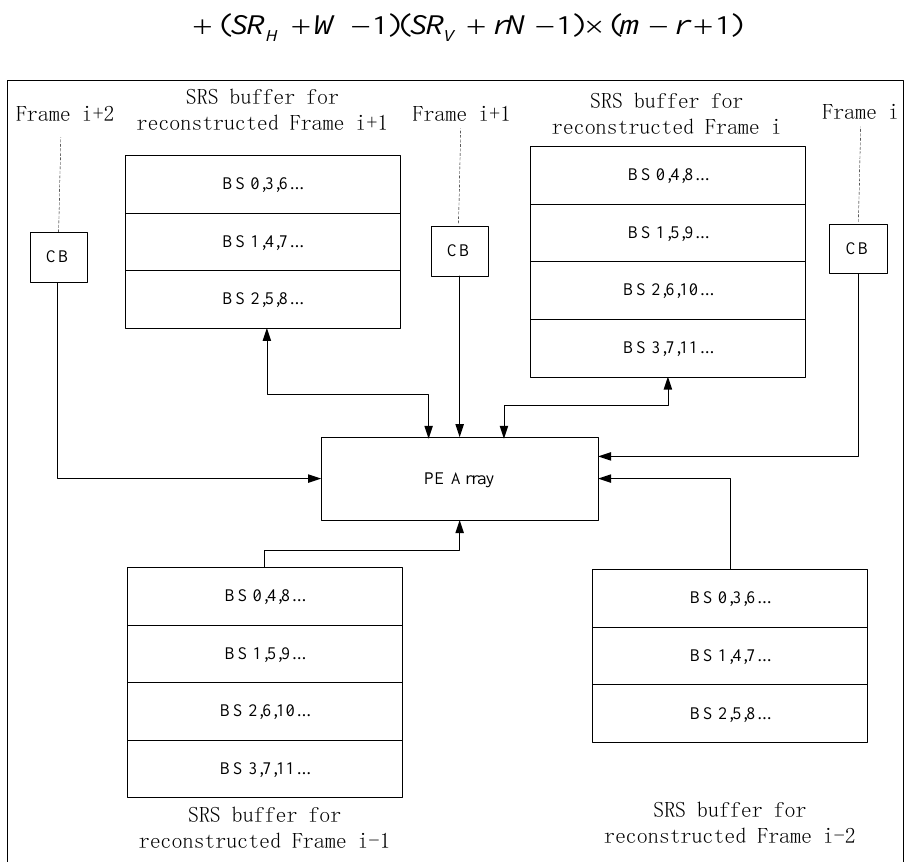
Figure 12. Inter-D architecture for VC-MRME. Three current frames (m = 3) are processed in the same time period, each with two reference frames (r =